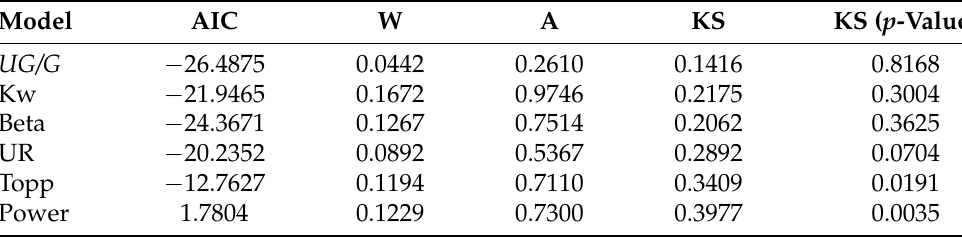
Table 12. AIC, W, A, KS, and KS ( p -value) values for the flood level data